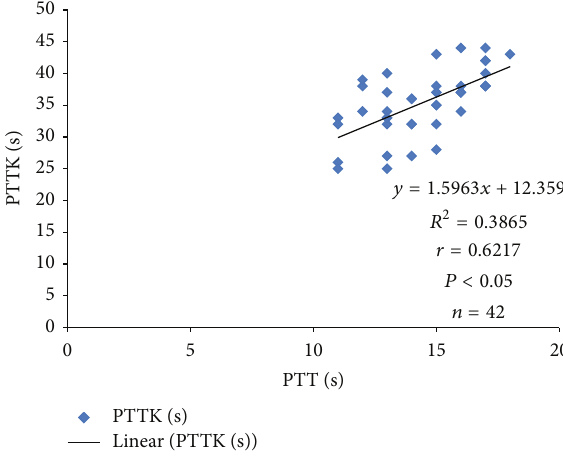
Figure 3: Correlation plot of PTTK against PTT in hypertensive patients.